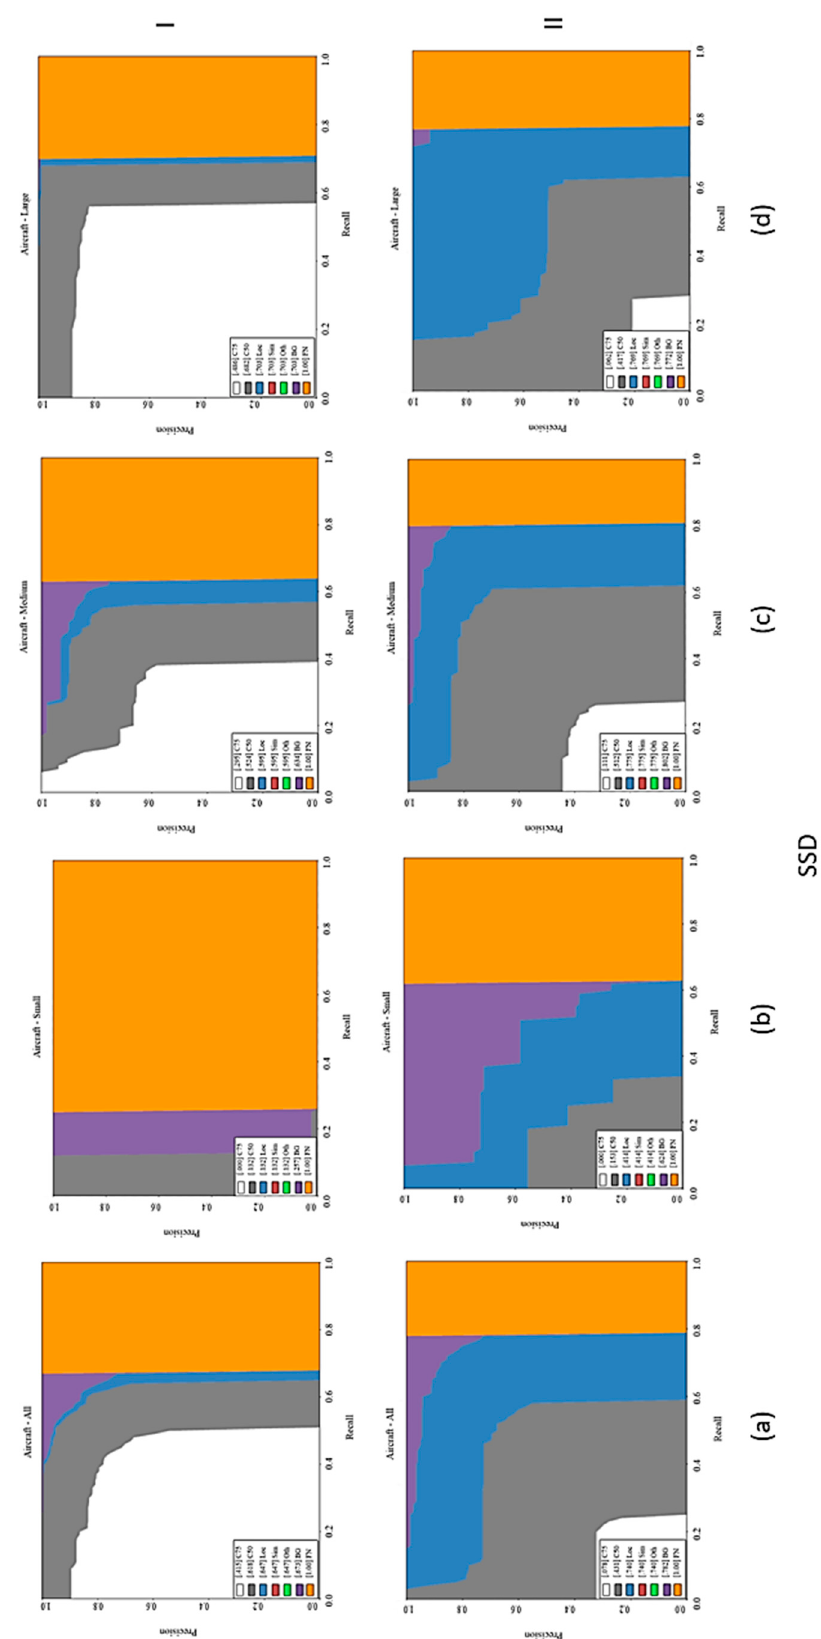
Figure A1. SSD Precision–recall curves for, ( a ) all object sizes, ( b ) small, ( c ) medium, ( d ) large object size obtained from, (I) DOTA test data and (II) Pleiades large-scale test image data.